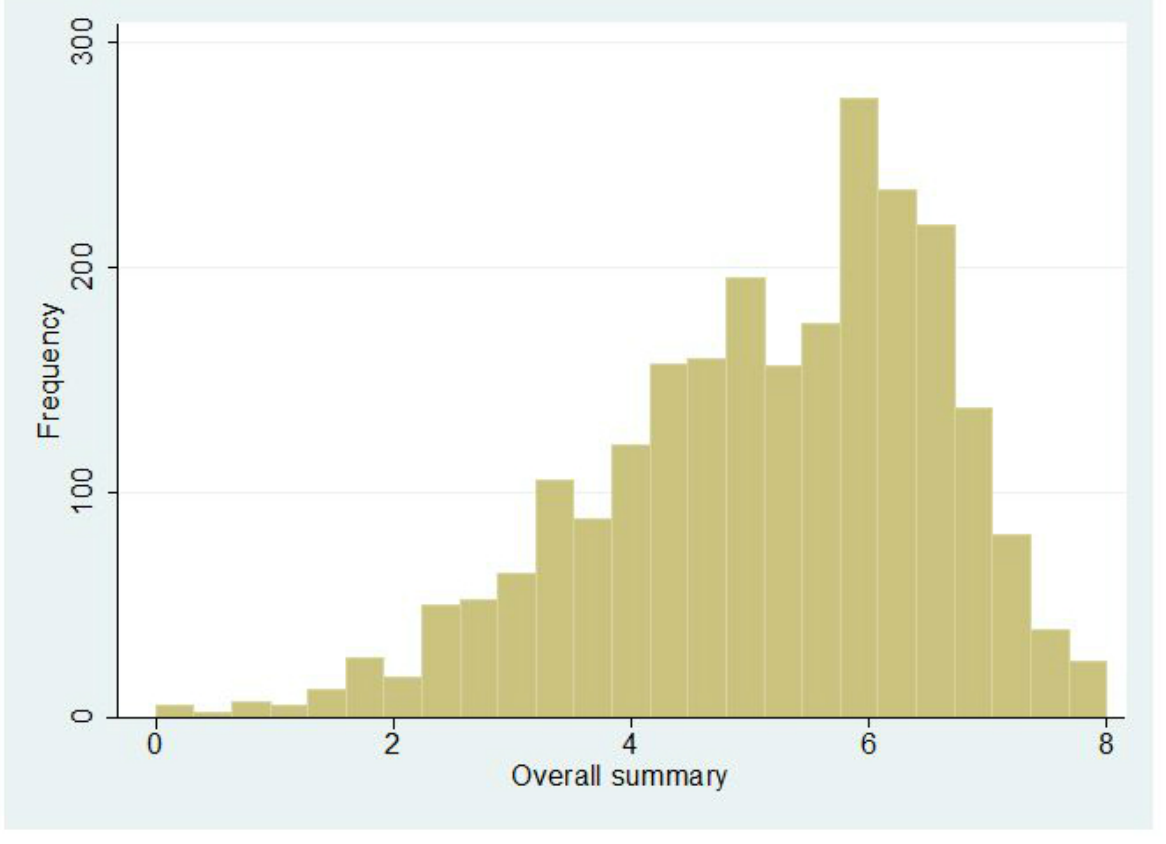
Figure 5. Distribution of scores: